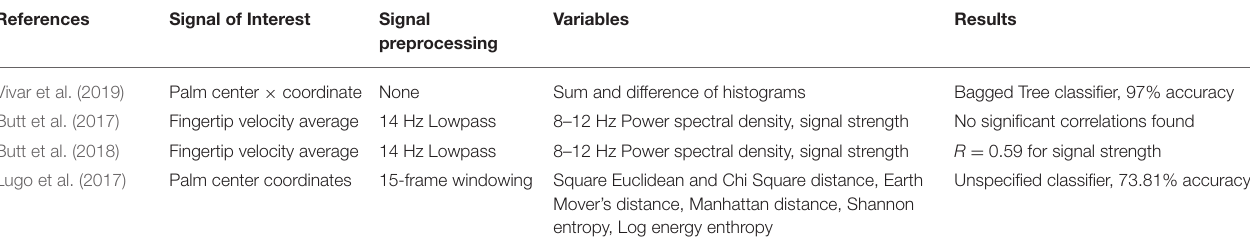
TABLE 3 | Classification results for